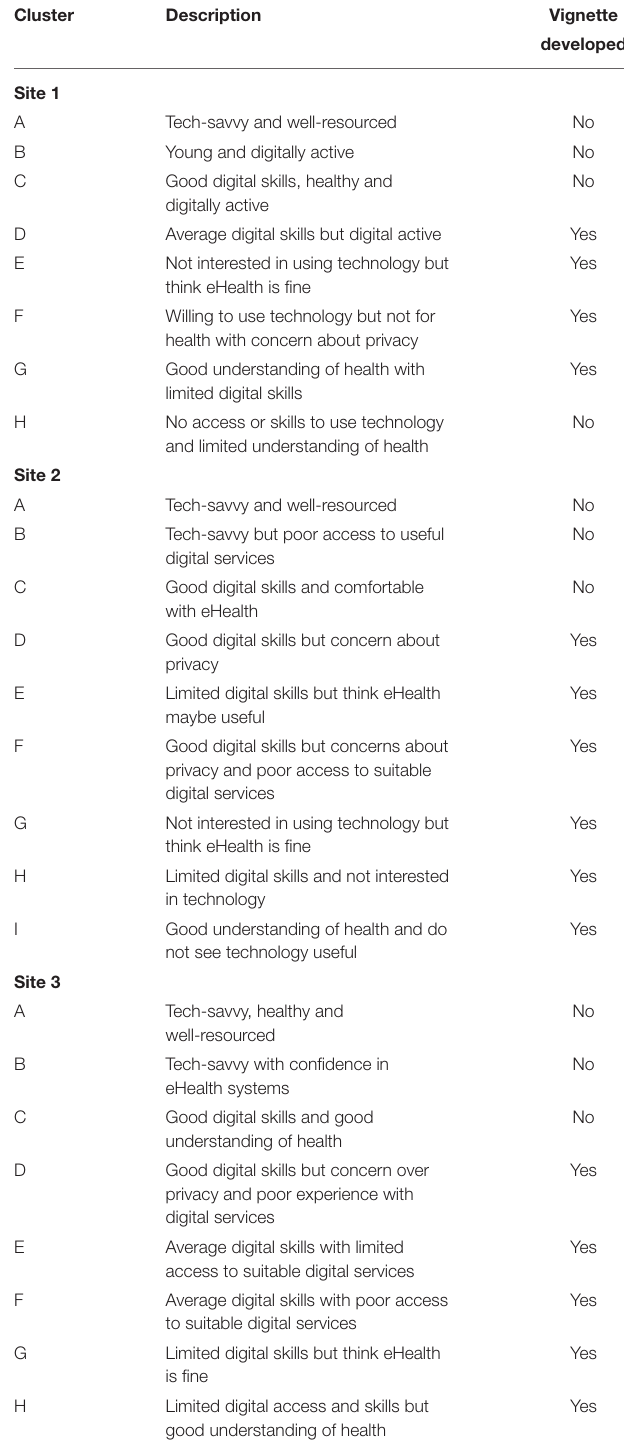
TABLE 5 | Description of clusters and vignettes.